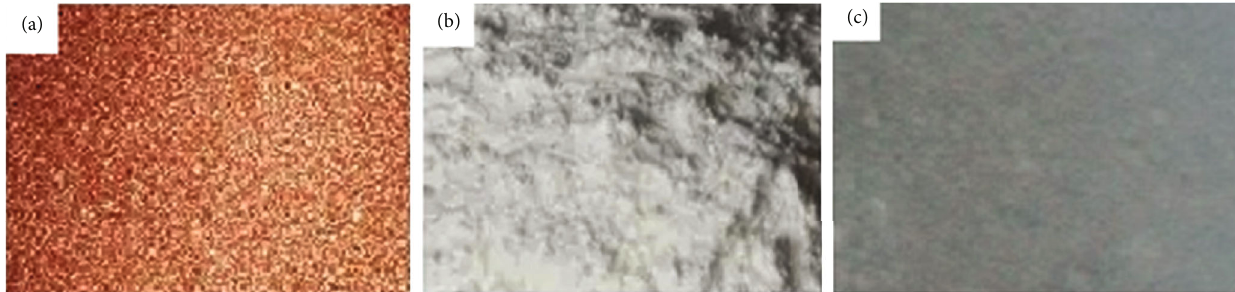
Figure 1: Actual illustrations for (a) copper metal particles, (b) alumina nanoparticles, and (c) graphite